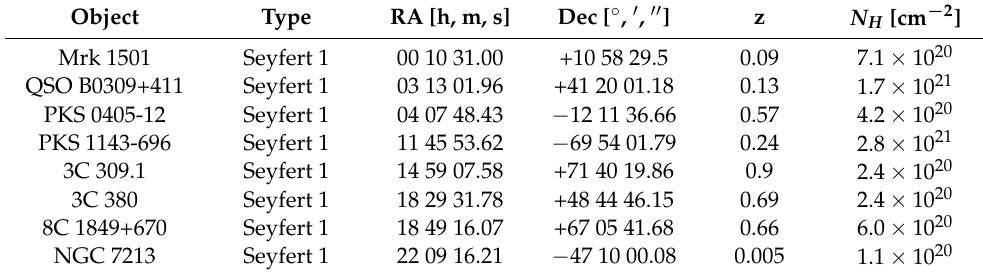
Table 3. Sub-sample of Seyfert 1 type